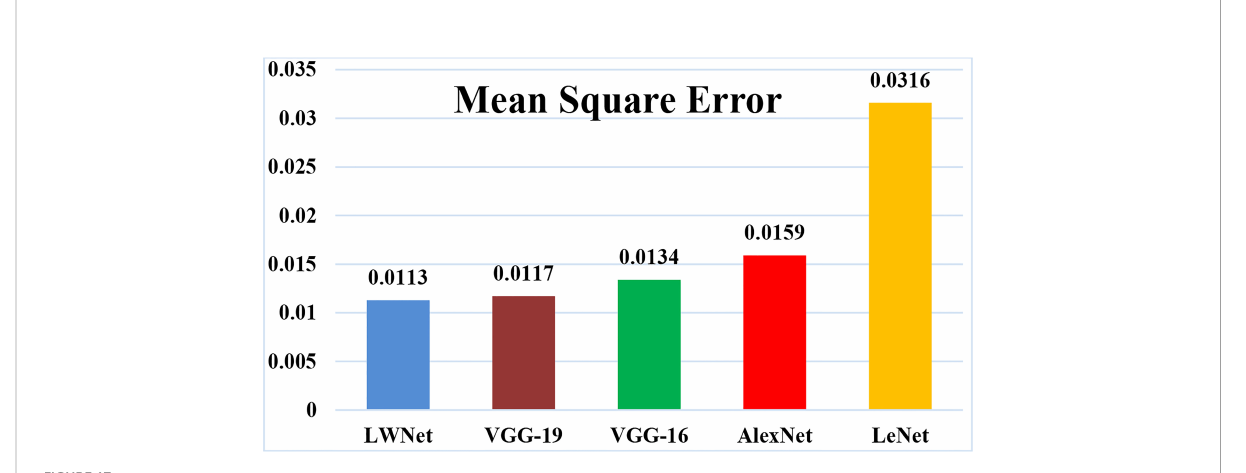
FIGURE 17 Mean square error of the simulation